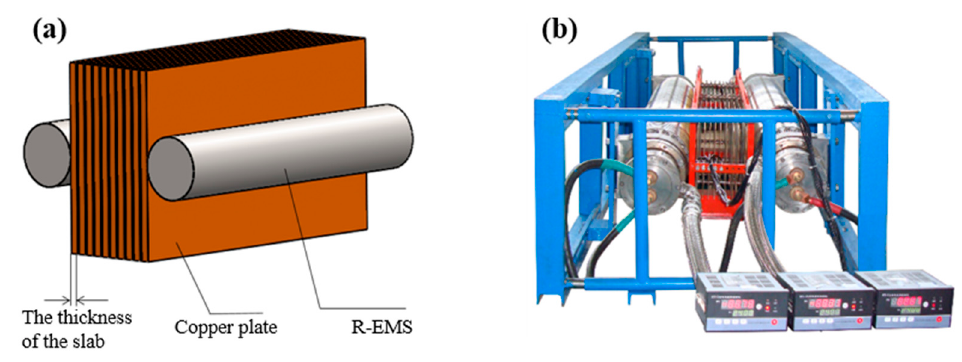
Figure 3. Copperplate measurement method: ( a ) Structure diagram; ( b ) physical device diagram.